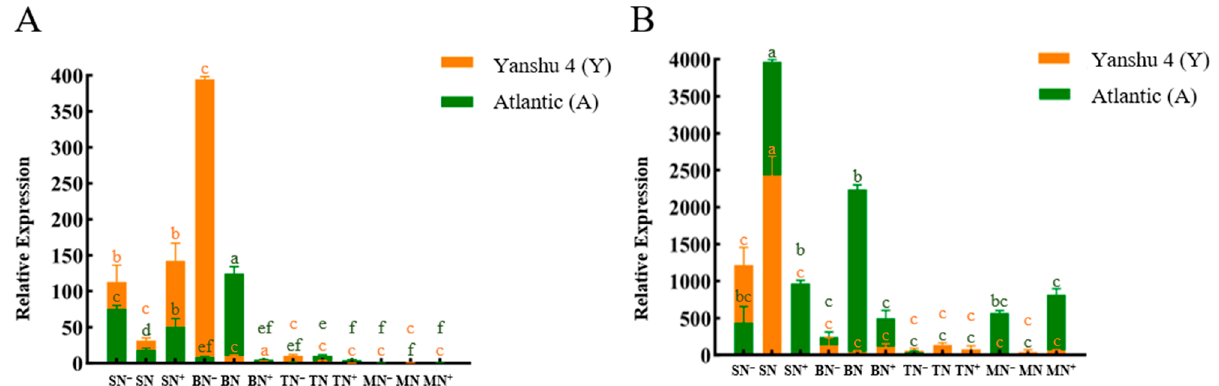
Figure 13. Relative expression of nitrate transporter StNRT2.5 in two genotypes of potato under different N supply levels. ( A ) Leaf (L); ( B ) Root (R). S, B, T, and M represent seedling stage, budding stage, tuber expansion stage, and mature stage, respectively. N − , N, N + are different N supply levels, representing low N, normal N, and excess N, respectively. Different letters indicate the difference of relative gene expression in different periods under different N application levels ( p <